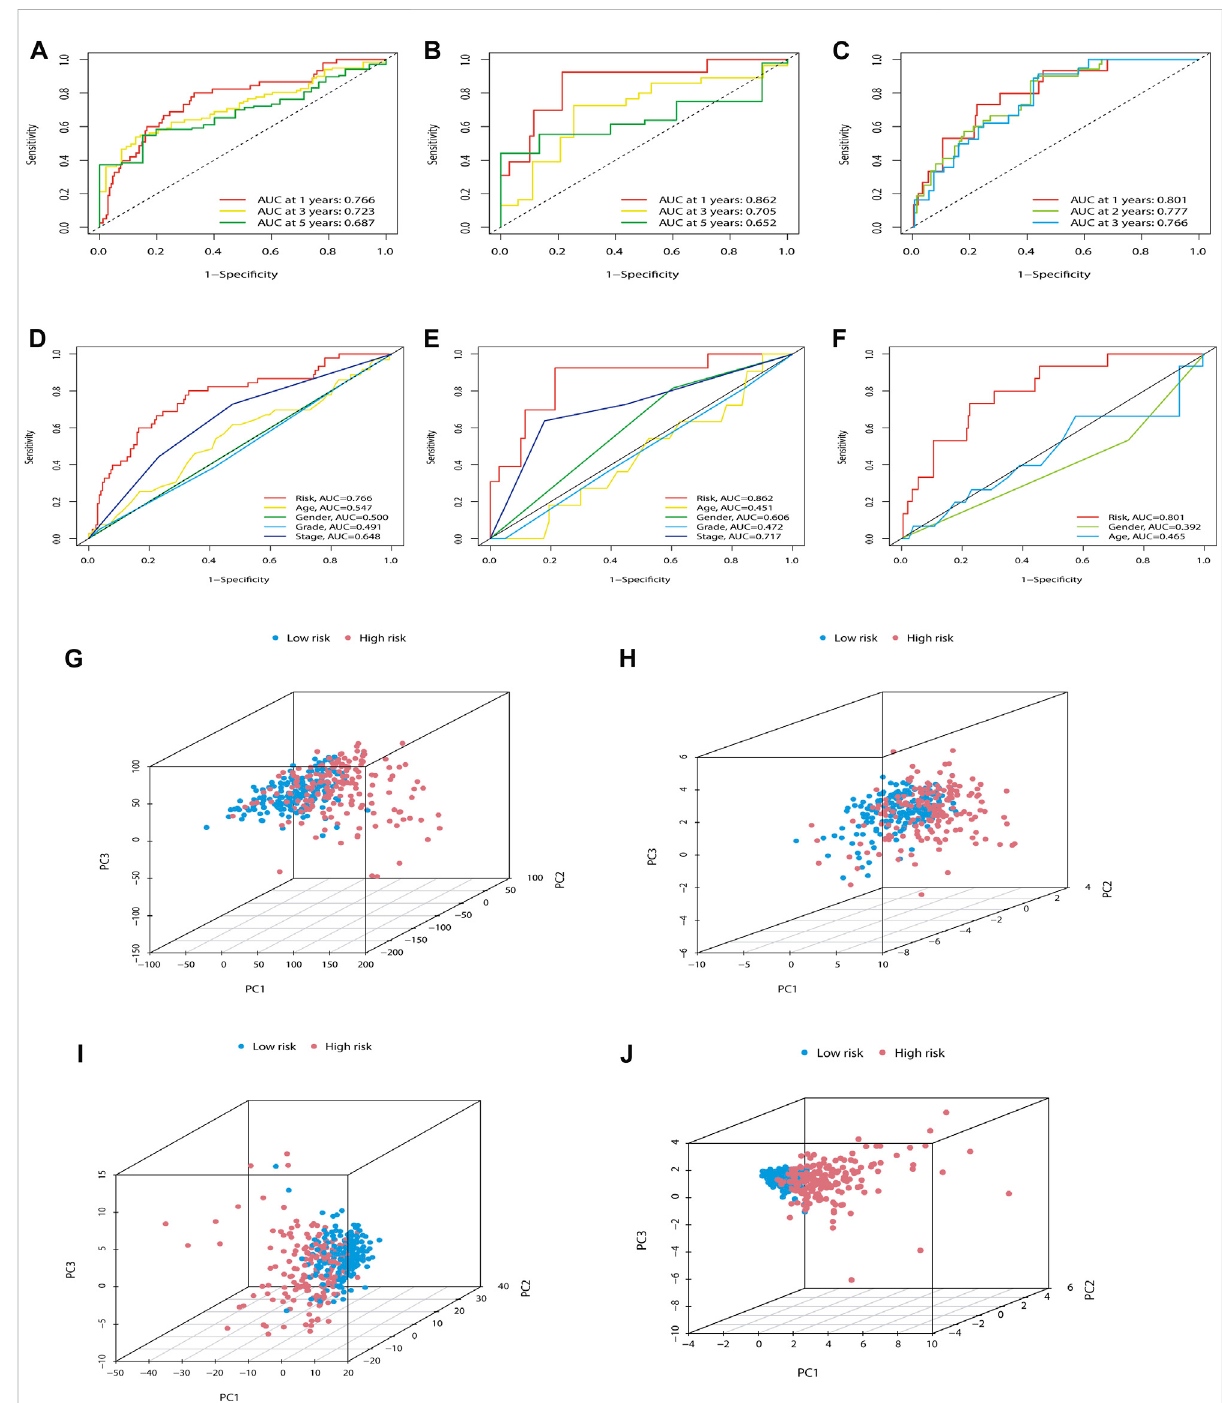
FIGURE 5 Further veri fi cation of the ability of the m7G-LPS. (A – C) ROC curves of m7G-PLS to predict the sensitivity and speci fi city of 1-, 3-, and 5-years survival in training (A) , testing (B) , and ICGC sets (C) . (D – F) The time-dependent AUC value with different clinical characteristics in the training, testing, and ICGC set. (G – J) PCA between the high- and low-risk groups based on whole gene expression pro fi les (G) , 29 m7G genes (H) , 22 prognostic m7G-related lncRNAs (I) , and m7G-LPS (J) . m7G, N7-methylguanosine; lncRNAs, long non-coding RNAs; m7G-LPS, m7G- related lncRNA prognostic signature; ROC, Receiver operating characteristic